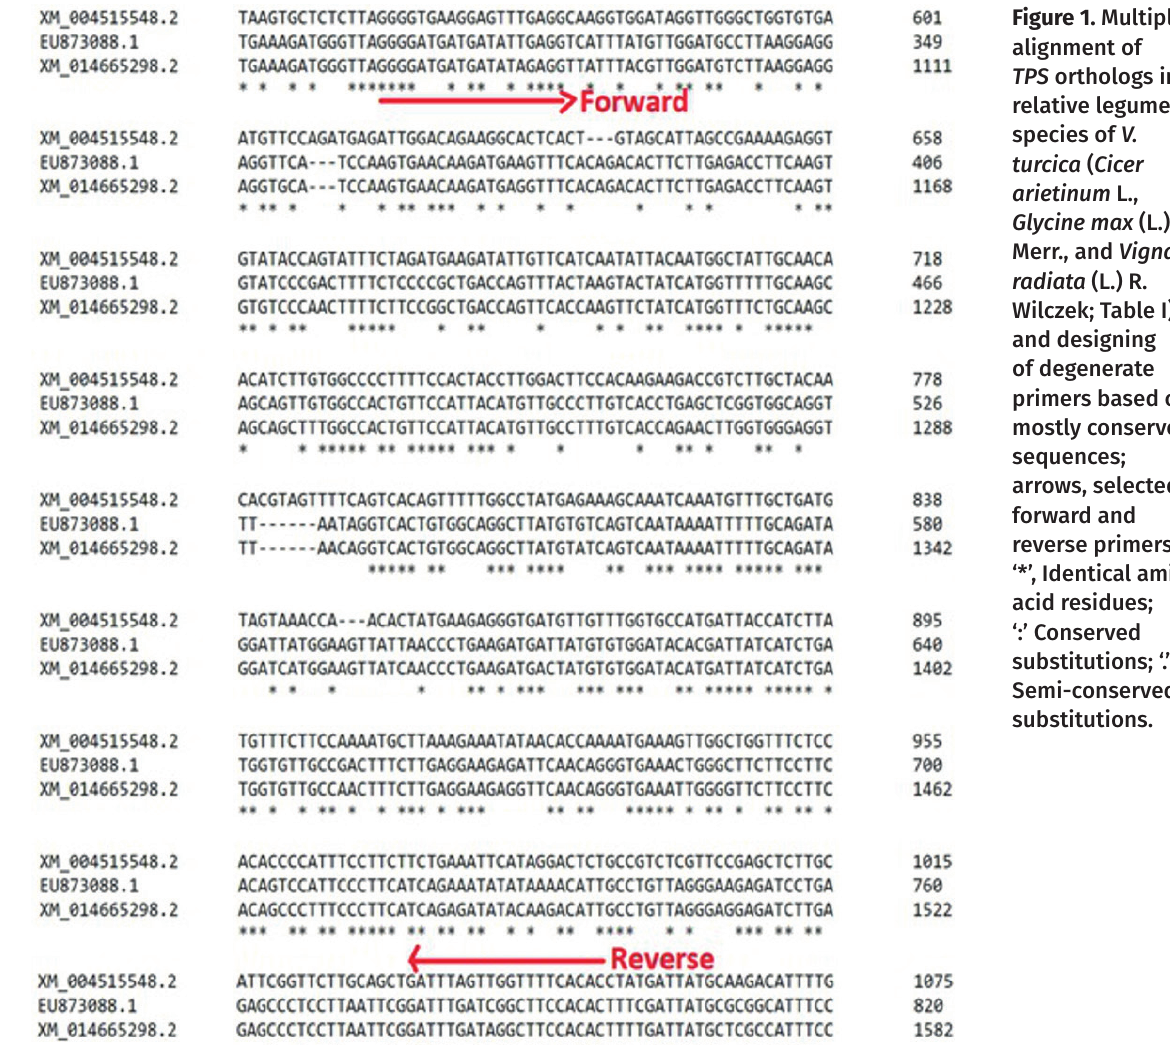
Figure 1. Multiple alignment of TPS orthologs in relative legume species of V. turcica ( Cicer arietinum L., Glycine max (L.) Merr., and Vigna radiata (L.)